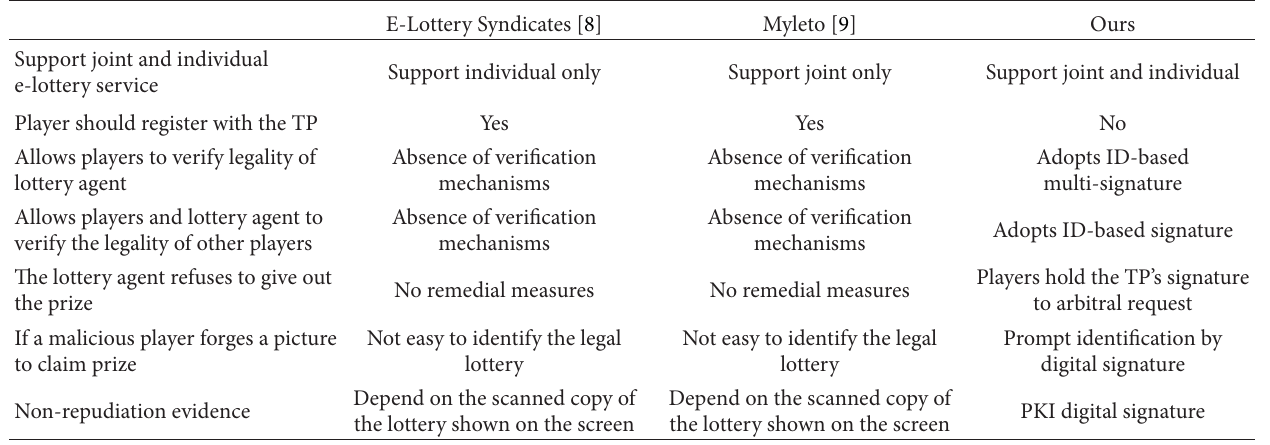
Table 3: Comparisons with the existing e-lottery